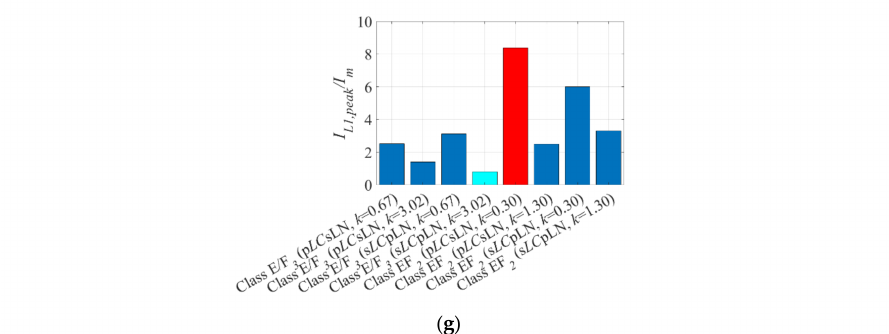
Figure 6. The normalized parameters recorded at the optimum condition ( D opt = 0.50 or 0.40, R L = R L,opt , low and high k ) ( a ) power output capability, c p ; ( b ) Efficiency, η (%); ( c ) normalized peak switch voltage, V S 1 ,peak / V in ; ( d ) normalized peak switch current, I S 1 ,peak / I m ; ( e ) normalized peak auxiliary resonant capacitor voltage, V C 1 ,peak / V in ; ( f ) normalized peak